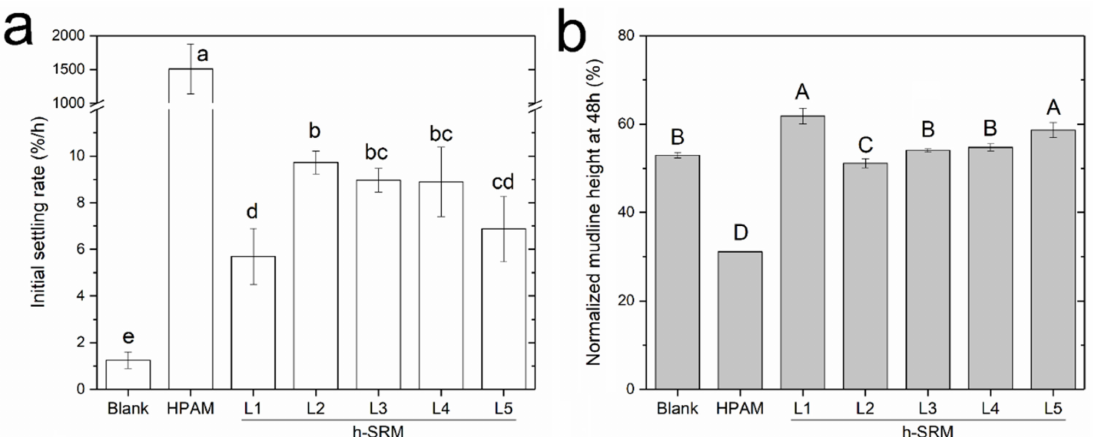
Figure 7. ( a ) Time-average Initial settling rate ( R i ) and ( b ) Normalized mudline height at 48 h of d-FFTs settling test. SRM-peptides are labelled as h-SRM, added at five dosage levels (L1–L5) being 4, 14, 22, 29, and 49 kg per ton of solids. Semi-bar represents the standard deviation of each experimental triplicate. Within each panel, bars that are annotated with the same letter ( a – d in panel a ; A – D in panel b ) are statistically similar at a 95% confidence